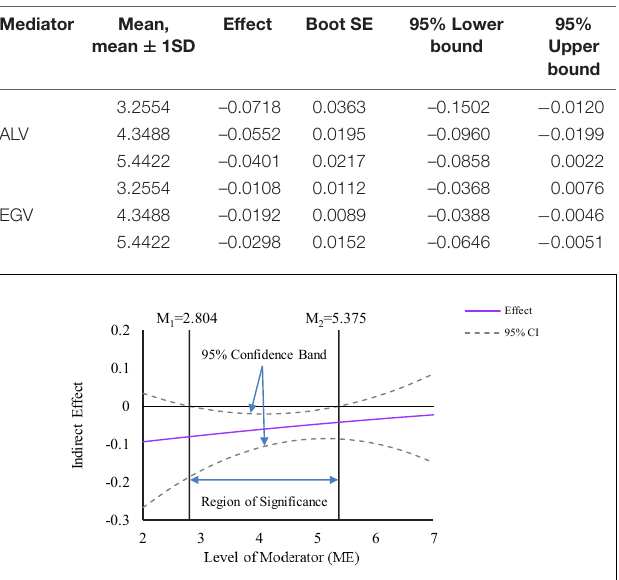
TABLE 5 | Results for moderated mediation effect ( N = 977).